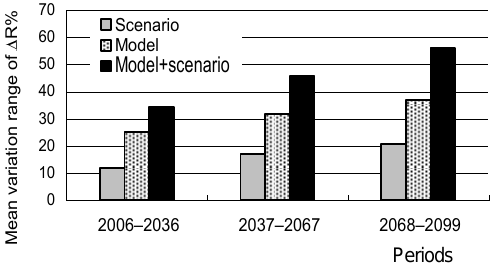
Figure 4. Mean variation range of projected relative changes in cli- matic river runoff (averaged over 11 river basins) due to differences in RCP scenarios (“Scenario”), GCMs (“Model”), as well as both scenarios and models (“Model +